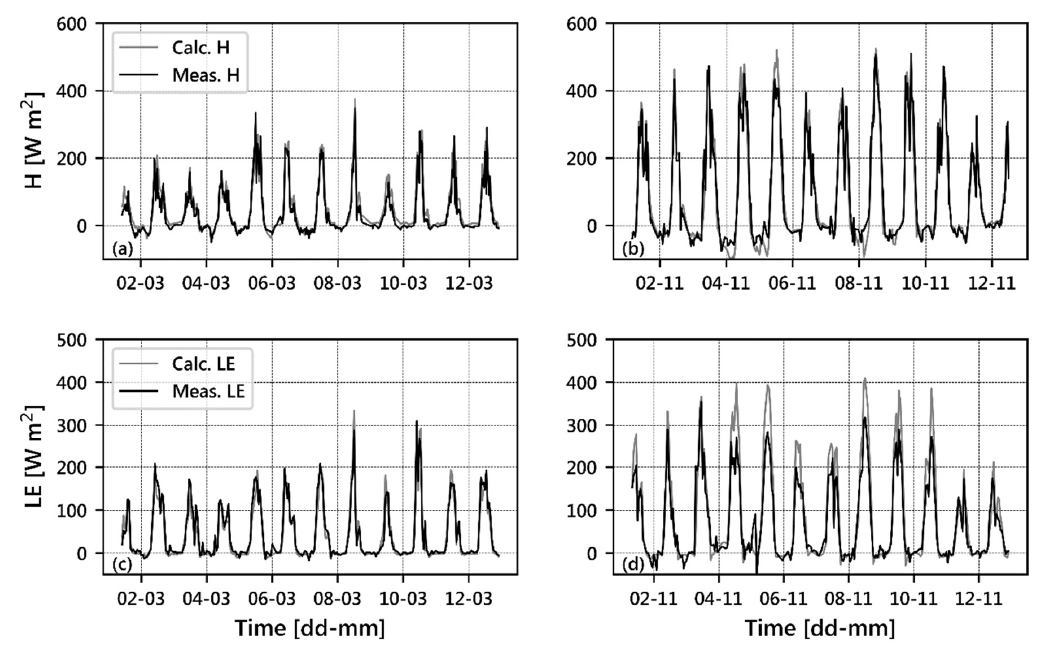
Figure 6. Time series of observed and estimated Sensible and Latent Heat Flux for a period for when estimations are the best ( a and c ) and for a period when estimations are worst ( b and d ). A t-test was performed for the four pairs of time series shown in the figure; the p -values were smaller than 0.05